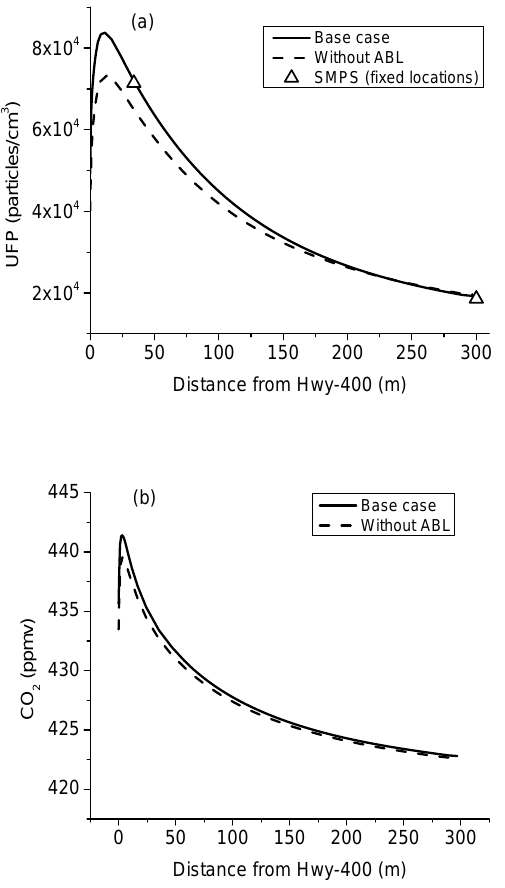
Figure 6. Predicted UFP number (a) and CO 2 (b) concentrations as Fig. 6. Predicted UFP number (a) and CO 2 (b) concentrations as a function of distance to 4 a function of distance to the center of Hwy the centre of Hwy-400. 5